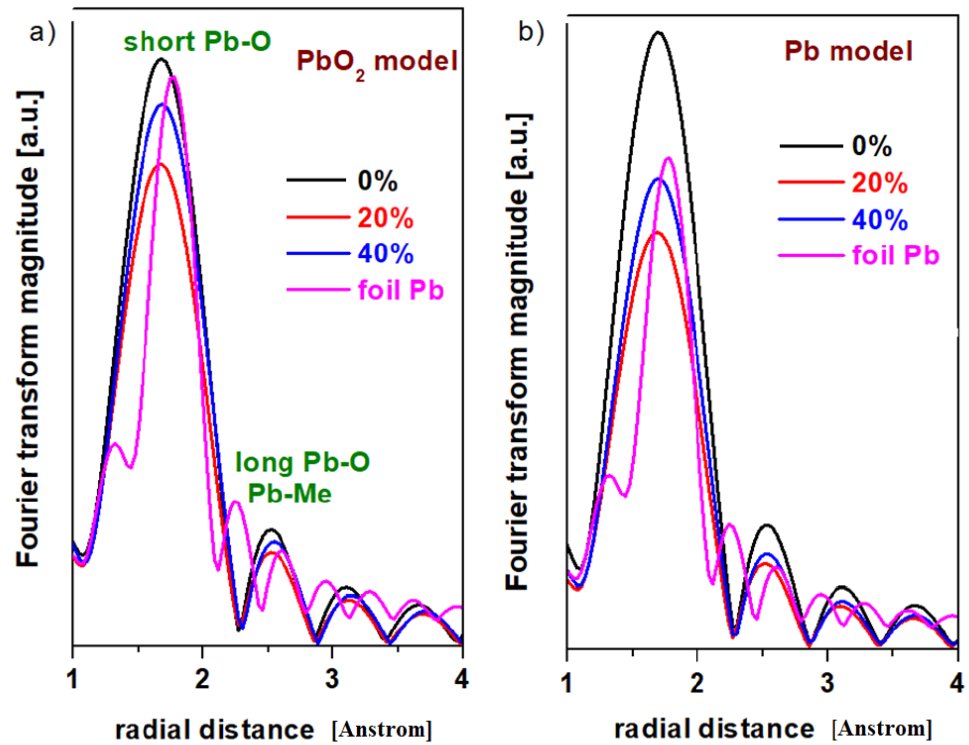
Figure 3. The radial distribution function of the lead atom for the vitroceramic system with chemical formula 15MnO 2 · 85[(100 − x)PbO 2 · xPb] where x = 0–40 mol% Pb. ( a ) the PbO 2 model ( b ) the Pb model.